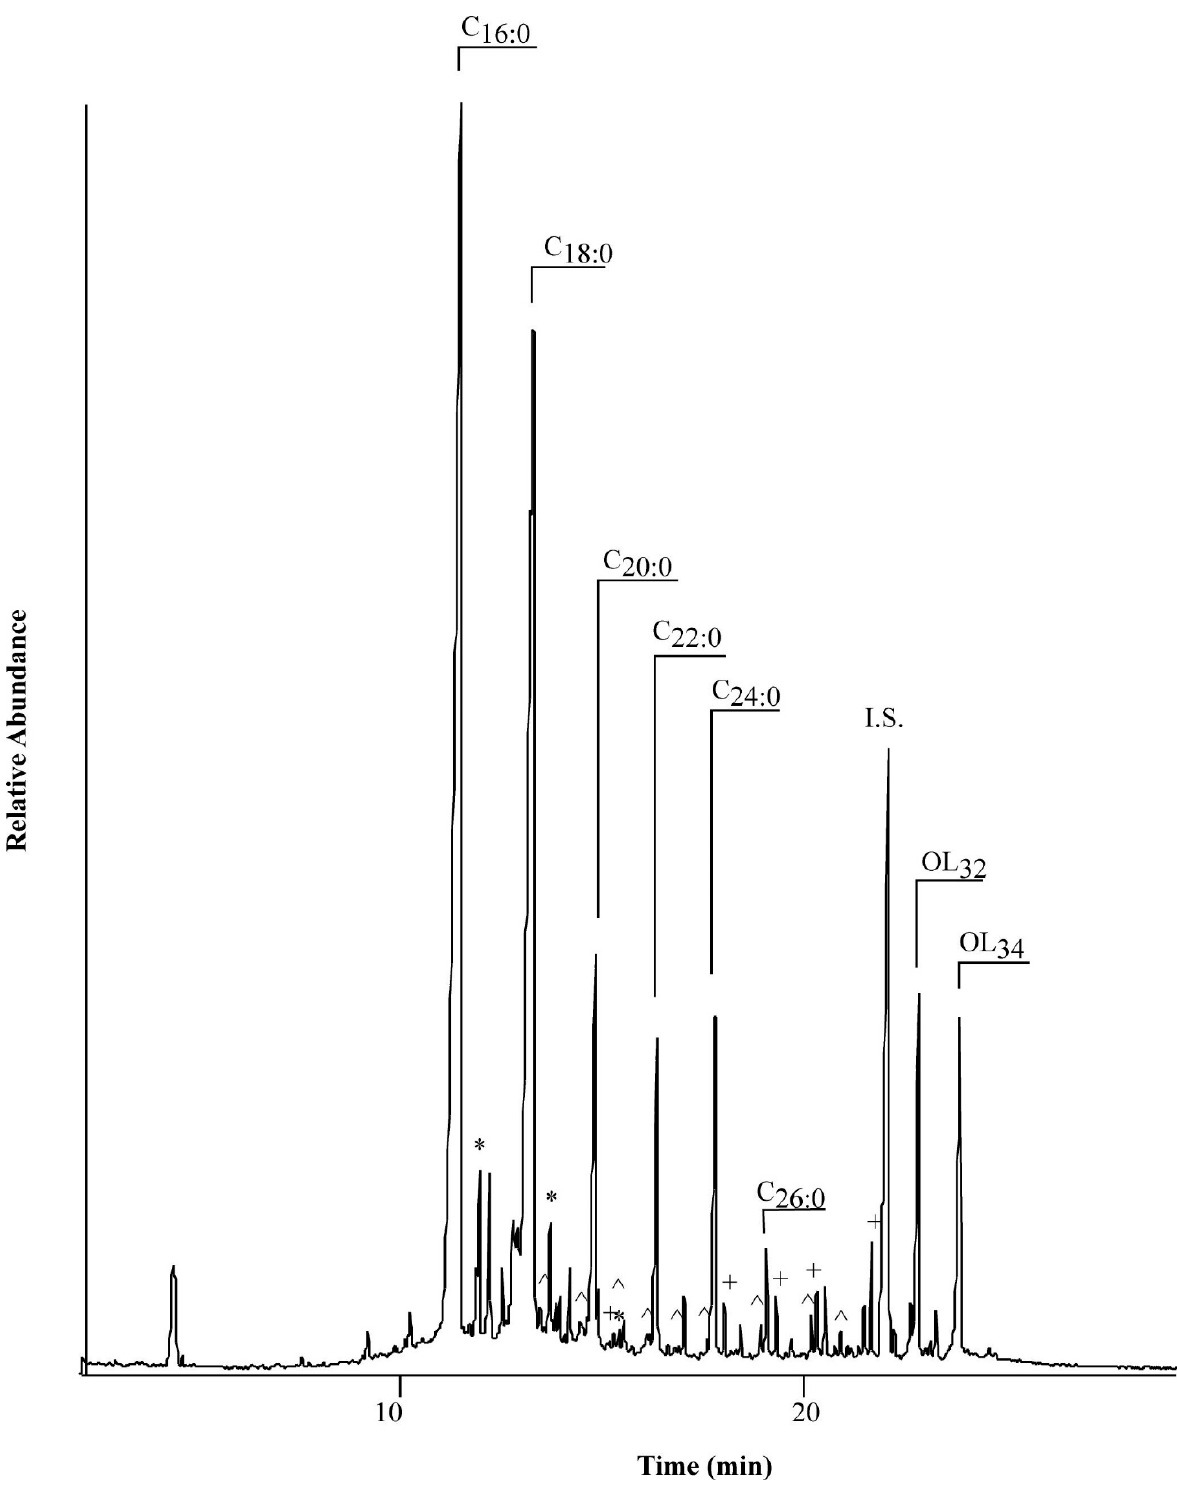
Figure 3. GC/MS of acidic methanol extraction from sample 10. Isoprenoid fatty acids are marked by *, alkanols by +, and alkanes by ^. Note the unusually abundant long-chain alkanols OL 32 and OL 34 .